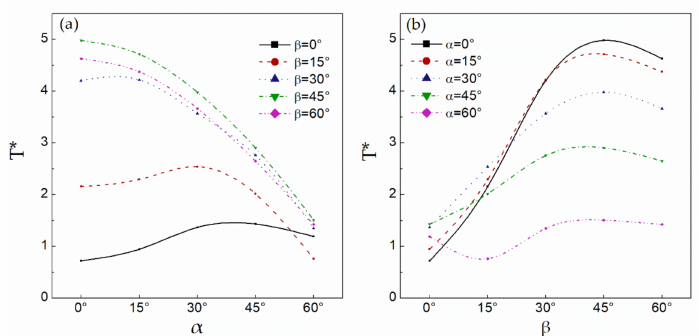
Figure 7. Variation of dimensionless T-stress T* with respect to horizontal deflection angle α and vertical deflection angle β . ( a ) The relationship between T* and α . ( b ) The relationship between T* and β